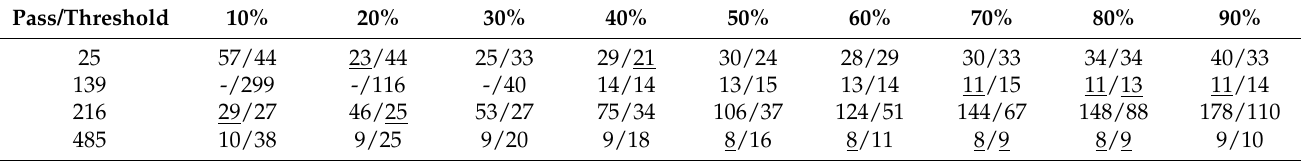
Table 6. RMSEs (cm) of the water level from retracking the full-waveform of decontaminated/modified waveforms (RMSE: decontaminated full-waveform/modified full-waveform).